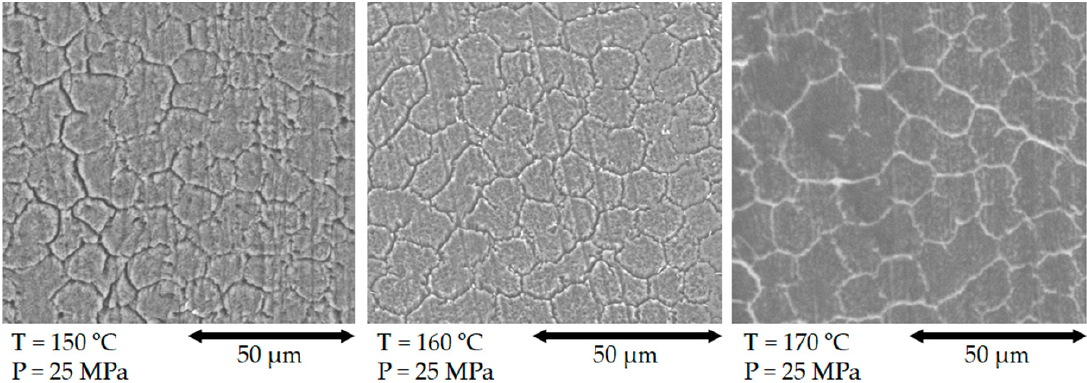
Figure 11. Cross-section of samples obtained 150 °C, 160 °C and 170 °C (25 MPa) (Regime 1).